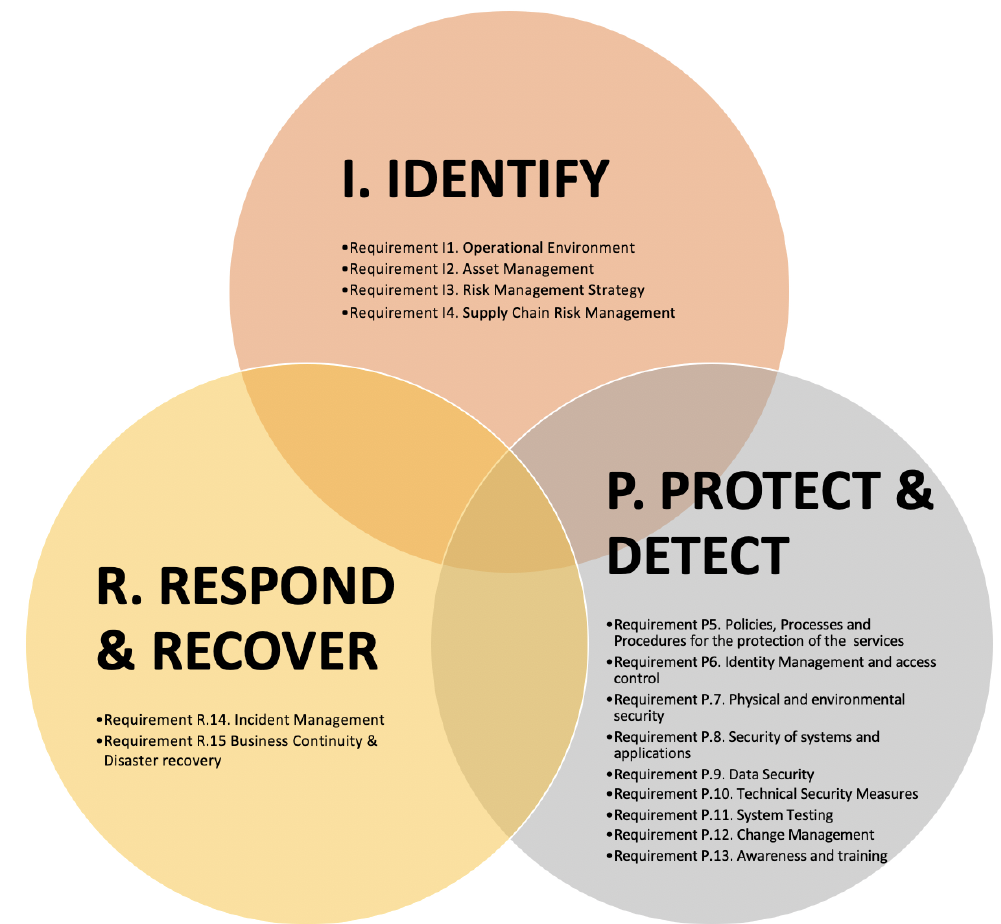
Figure 1. Holistic Cybersecurity Maturity Assessment Framework (HCYMAF) requirements are divided into three